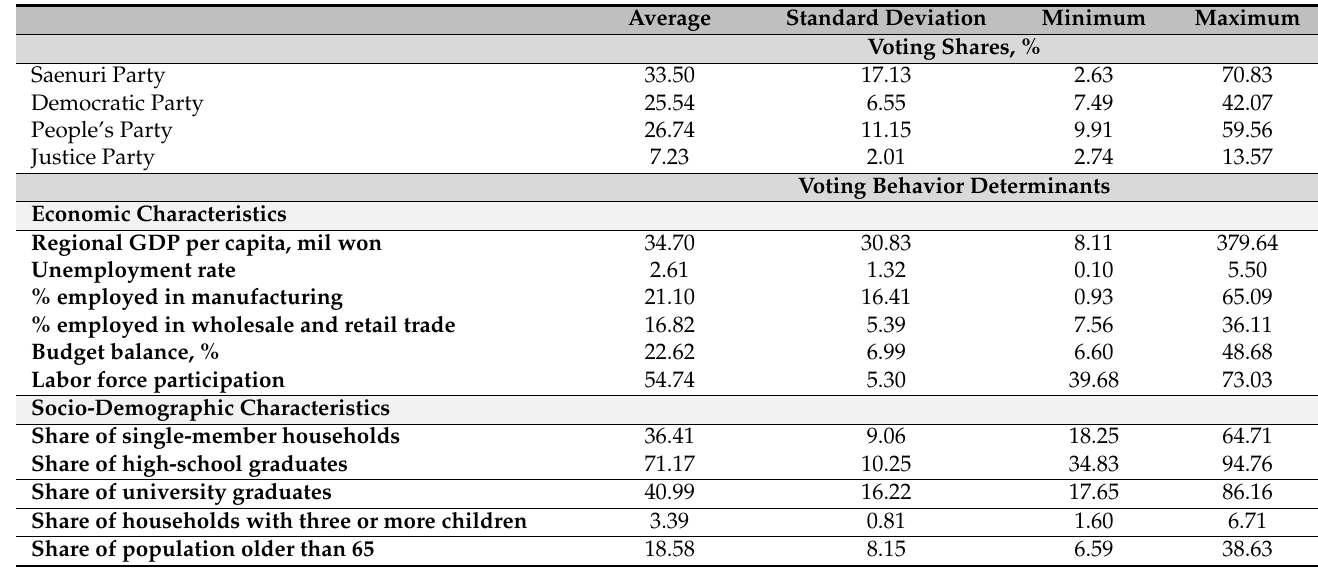
Table 1. Summary